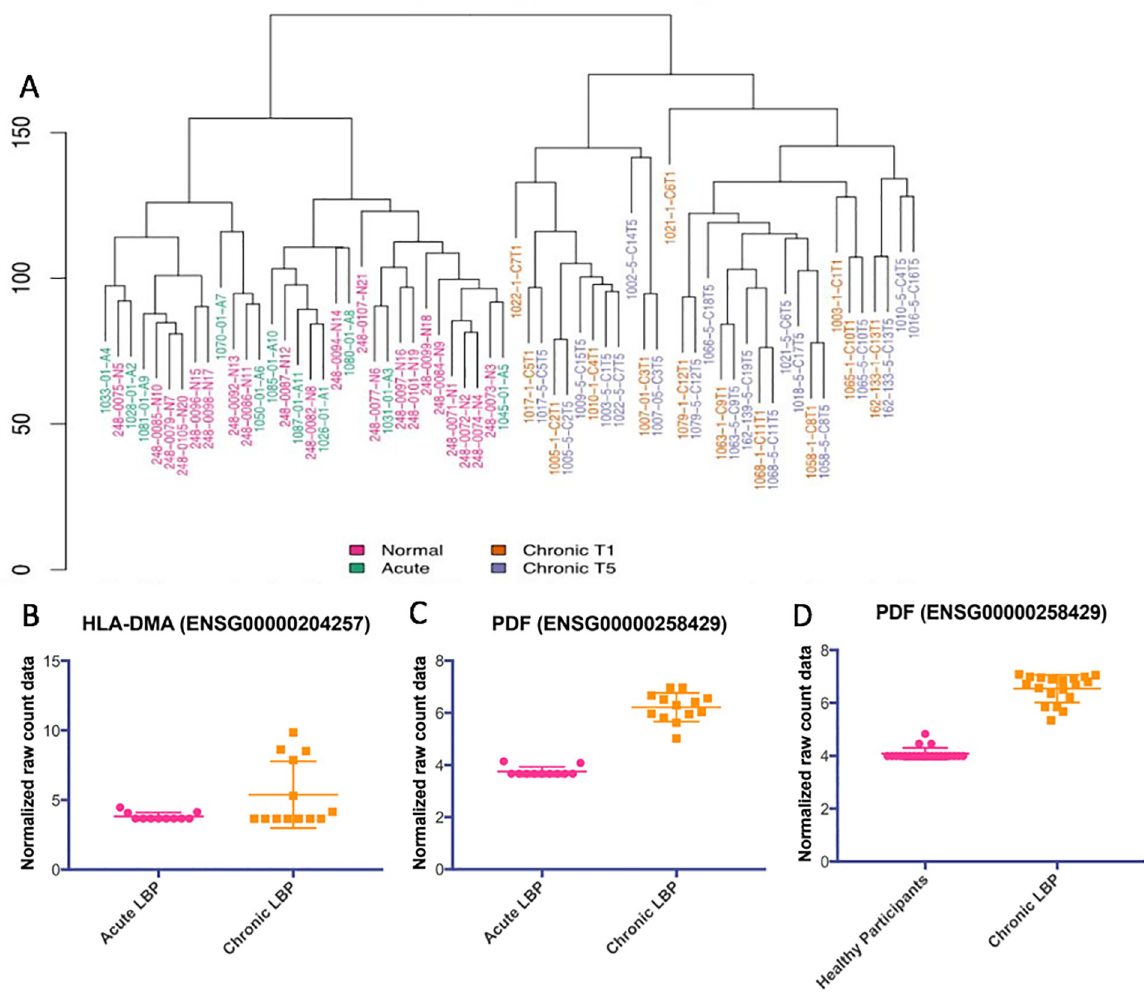
Fig 7. Characterization of differential gene expression in whole blood over the transition from acute to chronic low back pain. (A) Euclidean clustering demonstrates separation between normal control/acute group and chronic T1/T5. (B and C) HLA-DMA and PDF were the top 2 differentially expressed genes between the acute group and chronic T1 group. (D) PDF was significantly differentially expressed between normal controls and the chronic T5 group.